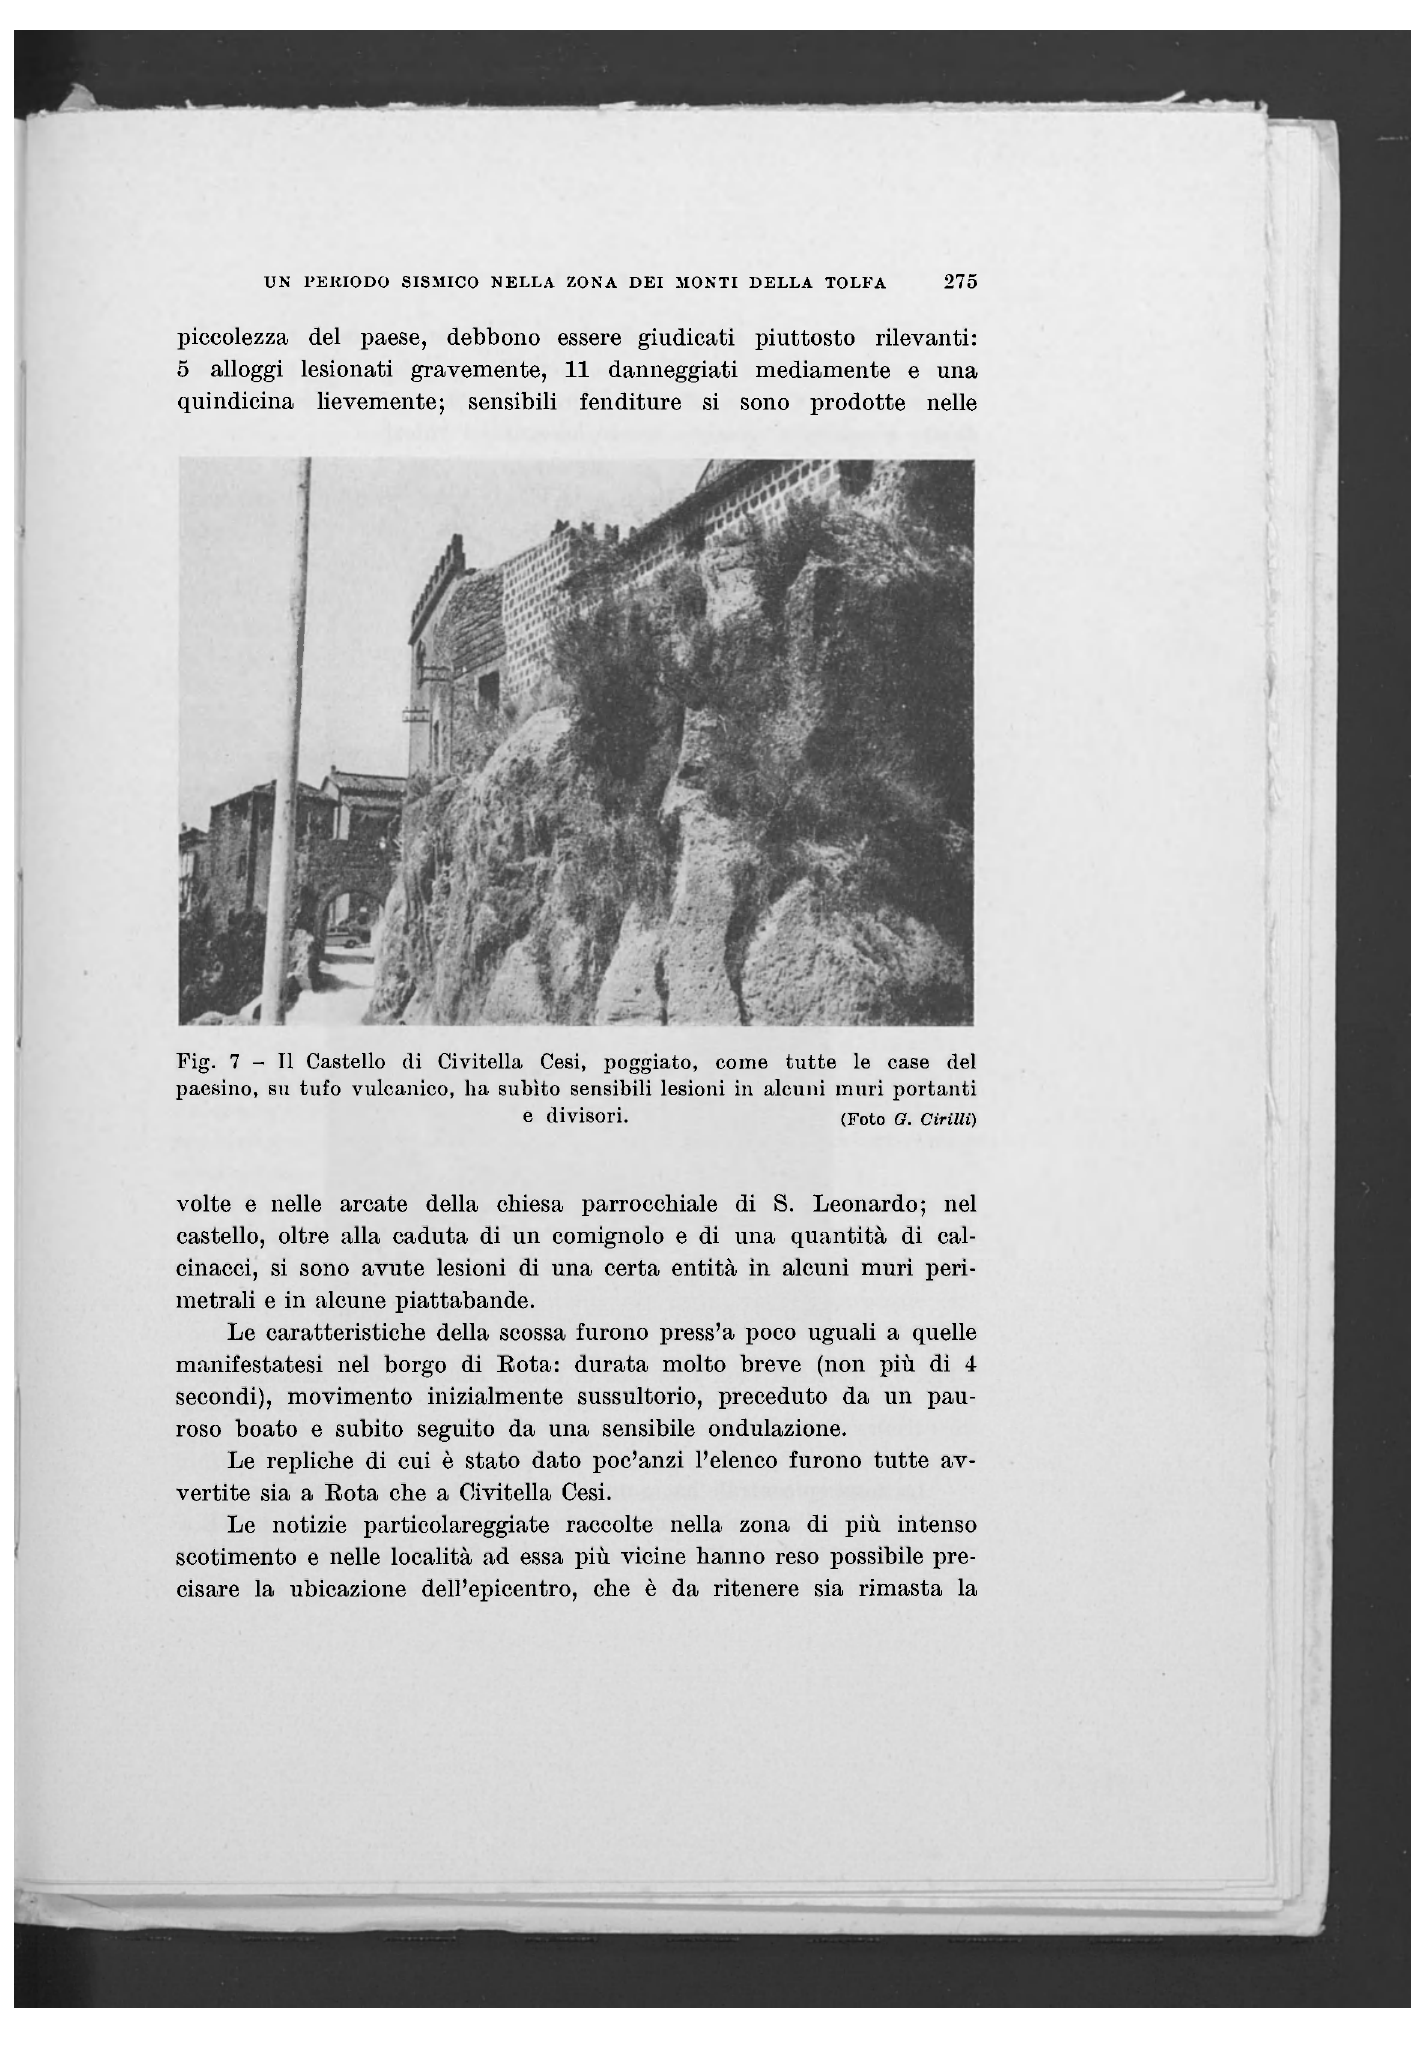
Fig. 7 - 11 Castello di Civitella Cesi, poggiato, come tutte le case